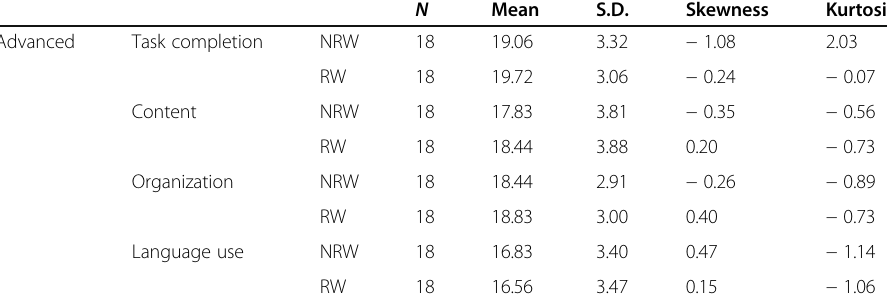
Table 7 Sub-score comparison of the high-proficiency group